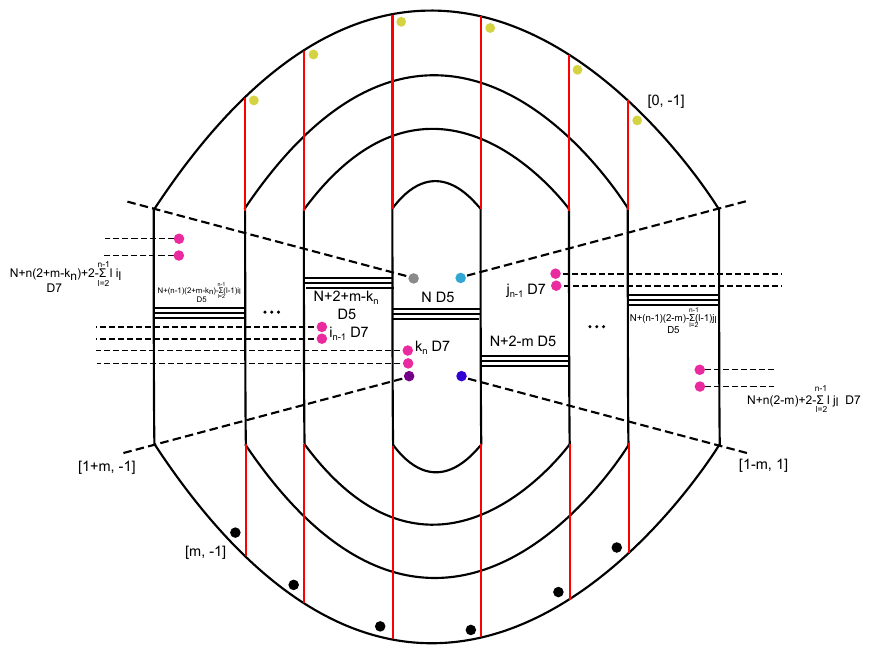
Figure 31 . Type IIB brane con(cid:12)guration after the two steps from the one in (cid:12)gure 30 when two O 7 (cid:0) -planes are